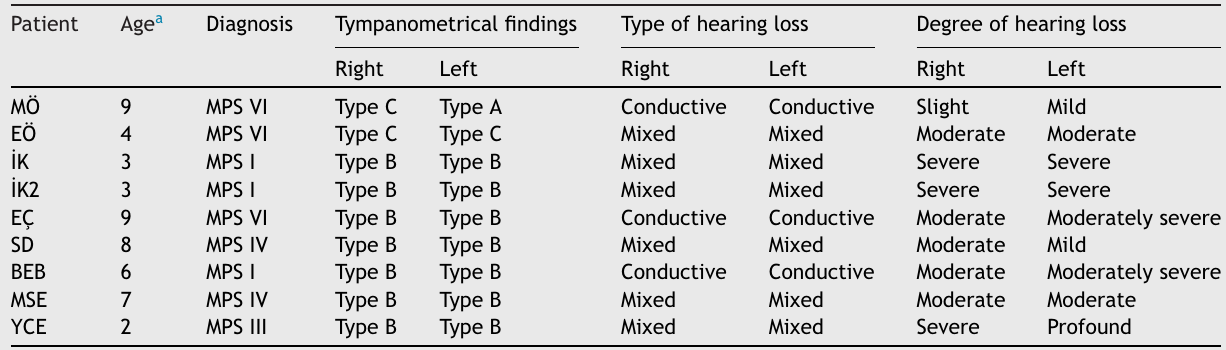
Audiometrical findings of patients with